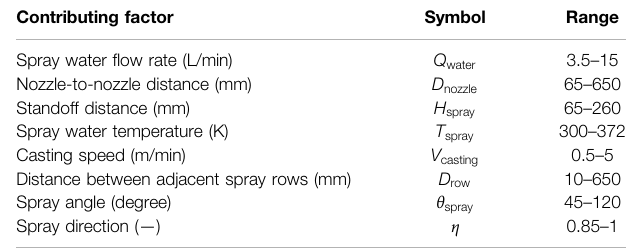
TABLE 1 | Summary of contributing factors applied in the current